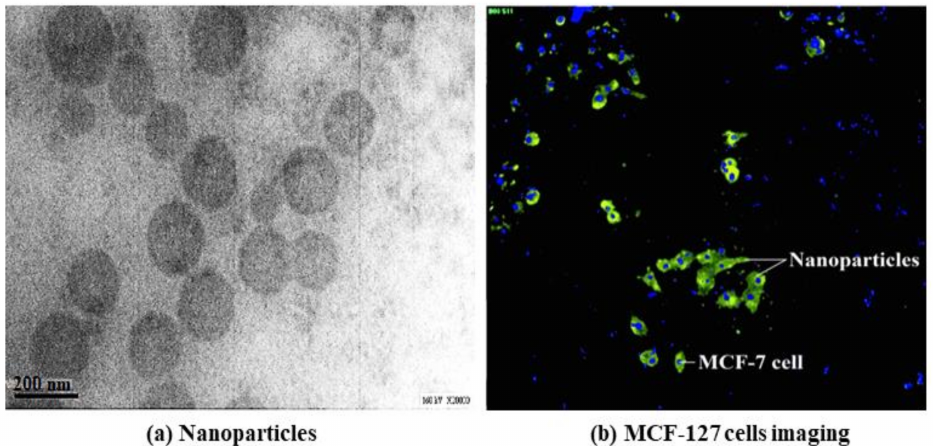
Figure 13. Peptide functionalised- and paclitaxel-loaded poly (APO- b -polyol ester) nanoparticles against MCF-7 cells. ( a ) Peptide was functionalised to poly(APO- b -polyol ester) nanoparticles using chemical conjugation technique and was loaded with paclitaxel; ( b ) Promising results were shown where the functionalised nanoparticles were found to be able to cause inhibition of human breast cancer cells. Source: unpublished